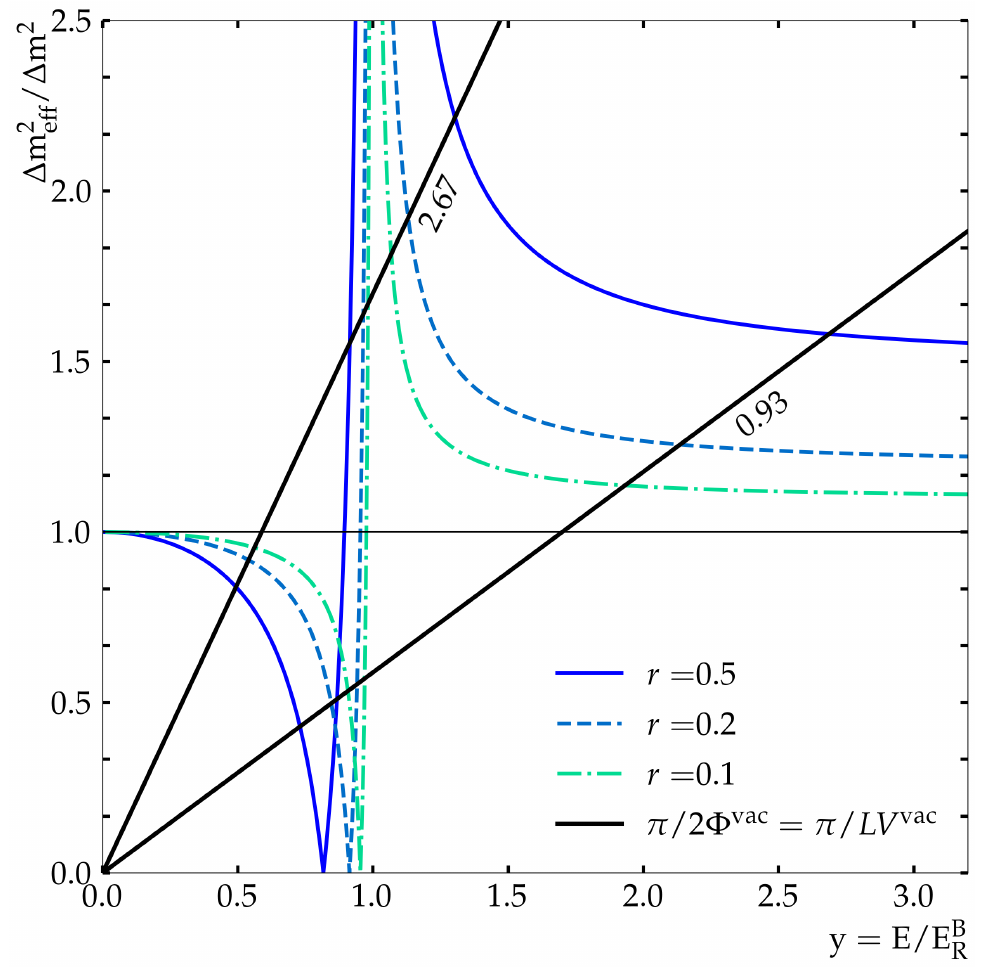
Figure 4 . The effective mass splitting ∆ m 2 / ∆ m 2 as function of y for different values of r . We eff take (cid:15) = 0 . Shown are also lines π/ 2 LV vac ( y ) which correspond to two different values of baseline (numbers at the lines). Crossings of these lines with ∆ m 2 π/ 2 LV vac / ∆ m 2 give the points where R eff the total phase Φ = π/ 2 (see text for